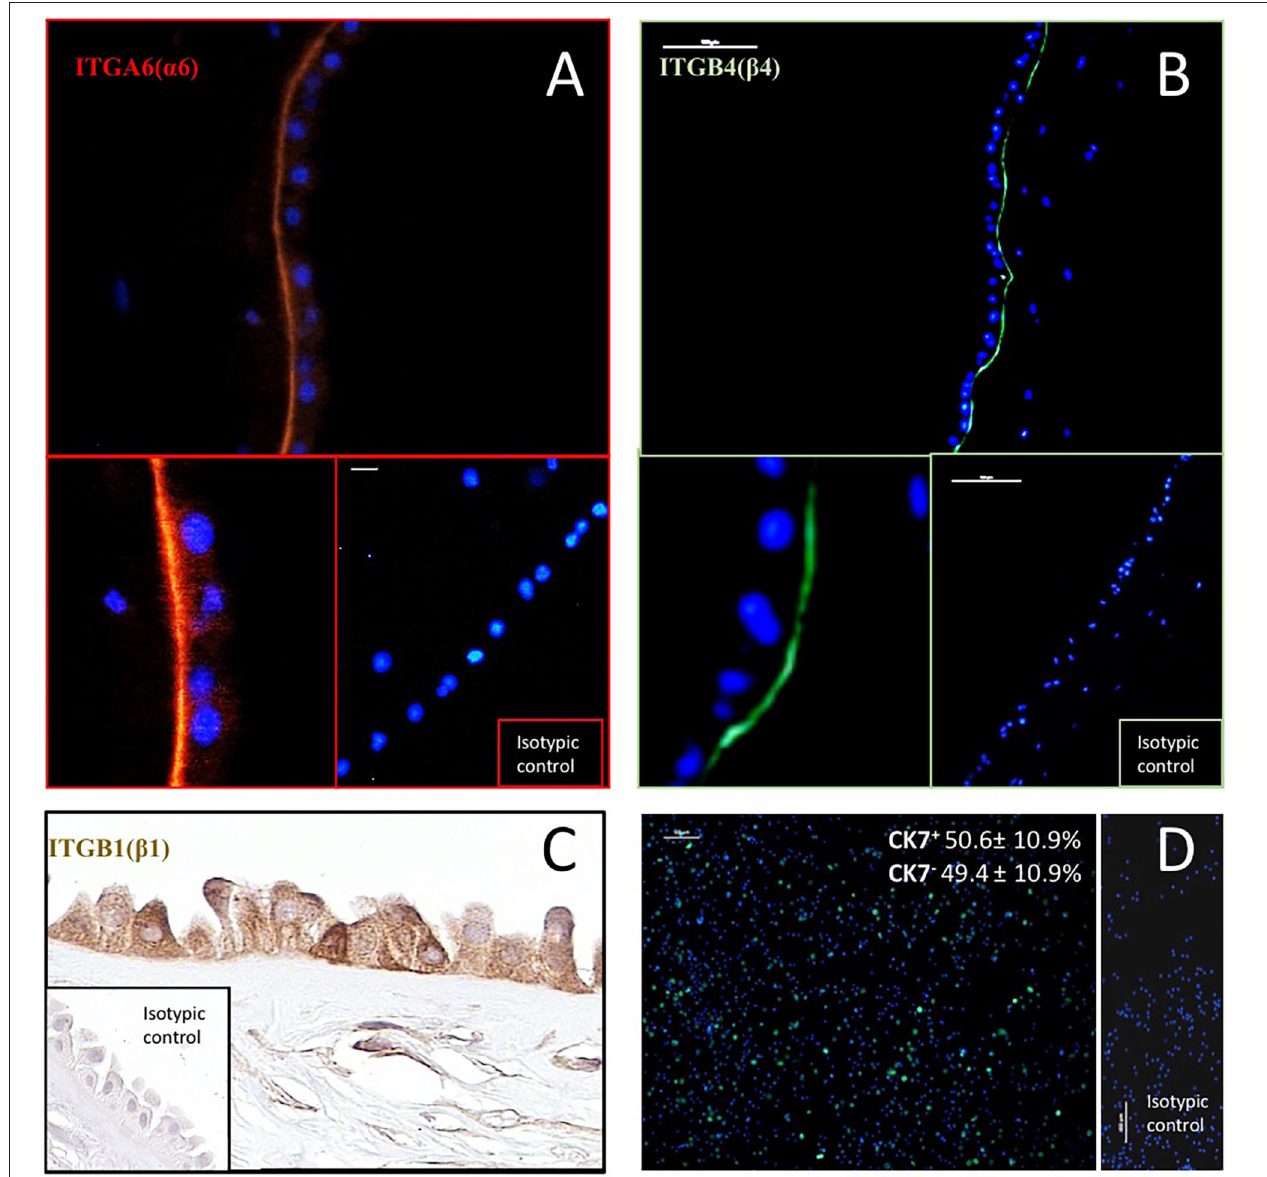
FIGURE 1 | Immunodetection of integrin subunits: ITGA6( α 6) (A) , ITGB1( β 1) (C) and ITGB4( β 4) (B) in human amnion, and cytokeratin 7 (CK7)–a marker of epithelial cells–in hAC after 12h of culture (D) . In immunofluorescence (A,B) , antibodies were conjugated with TRIC (orange) and Alexa Fluor 488 (green). Anti-CK7 antibody was conjugated with DyLight 480 (green). Cell nuclei were stained with DAPI (blue). Percentage of CK7 + and CK7 − hAC cells (mean ± SD) is also given ( n = 10). ITGB1 was detected by immunohistochemical ABC method. Magnification: ITGA6–200 x, and 400 x , scale 10 µ m; ITGB4–100 x, and 400 x , scale 100 µ m; ITGB1–400 x ; CK-7–100 x , scale 100 µ